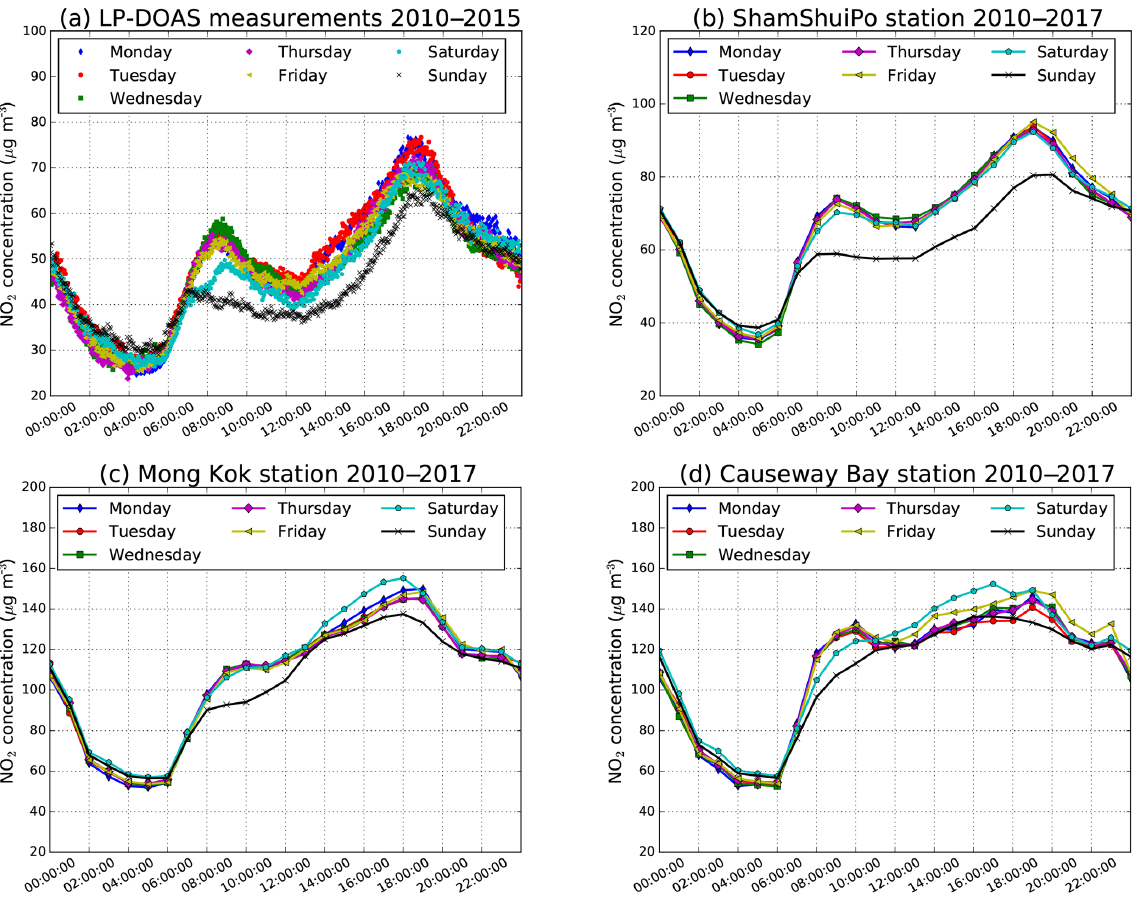
Figure 10. Panel (a) shows the 5-year average diurnal cycle of NO 2 of each day of the week was measured by LP-DOAS. The 7-year average diurnal cycle of NO 2 of each day of the week measured by EPD at (b) Sham Shui Po station, (c) Mong Kok station and (d) Causeway Bay